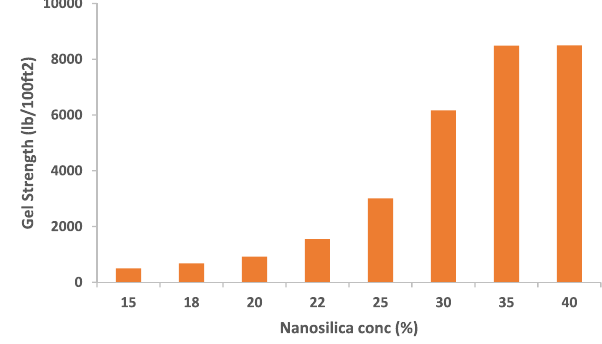
Fig. 5 The gel strength versus nano-silica